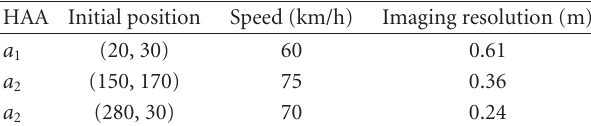
Table 1: Parameters for high-altitude airships simulation.